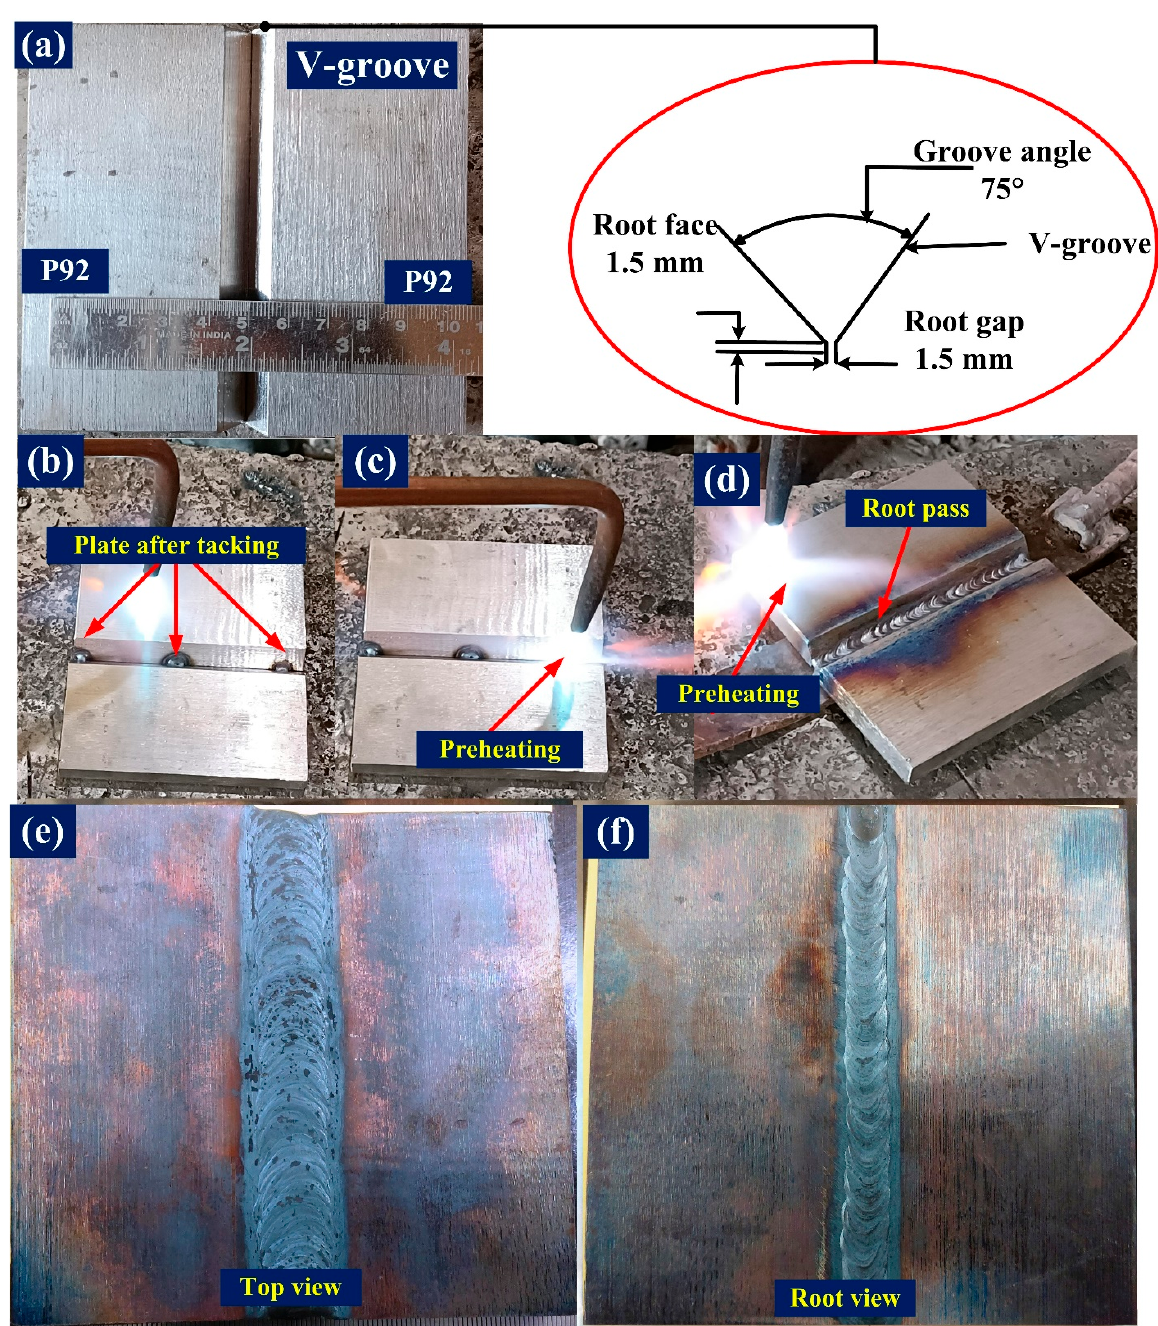
Figure 1. ( a ) Grooved plate and detail of groove geometry, ( b ) plate after tacking, ( c ) preheating, ( d ) root pass, ( e ) top view of plate, ( f ) root view of the plate. Table 2. Welding parameters.